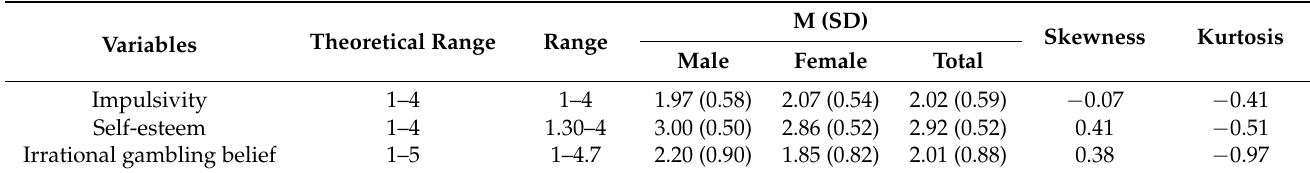
Table 1. Descriptive statistics of the main variables ( n male = 259, n female = 304).